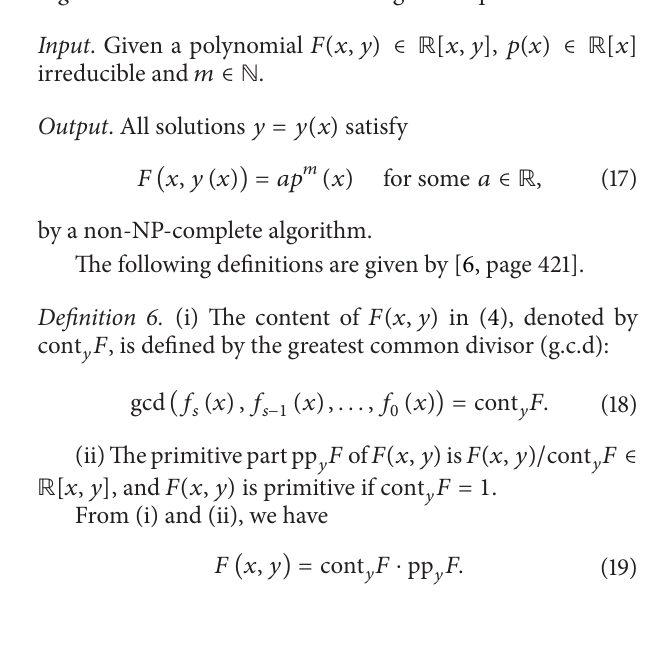
Algorithm 5. Consider the following